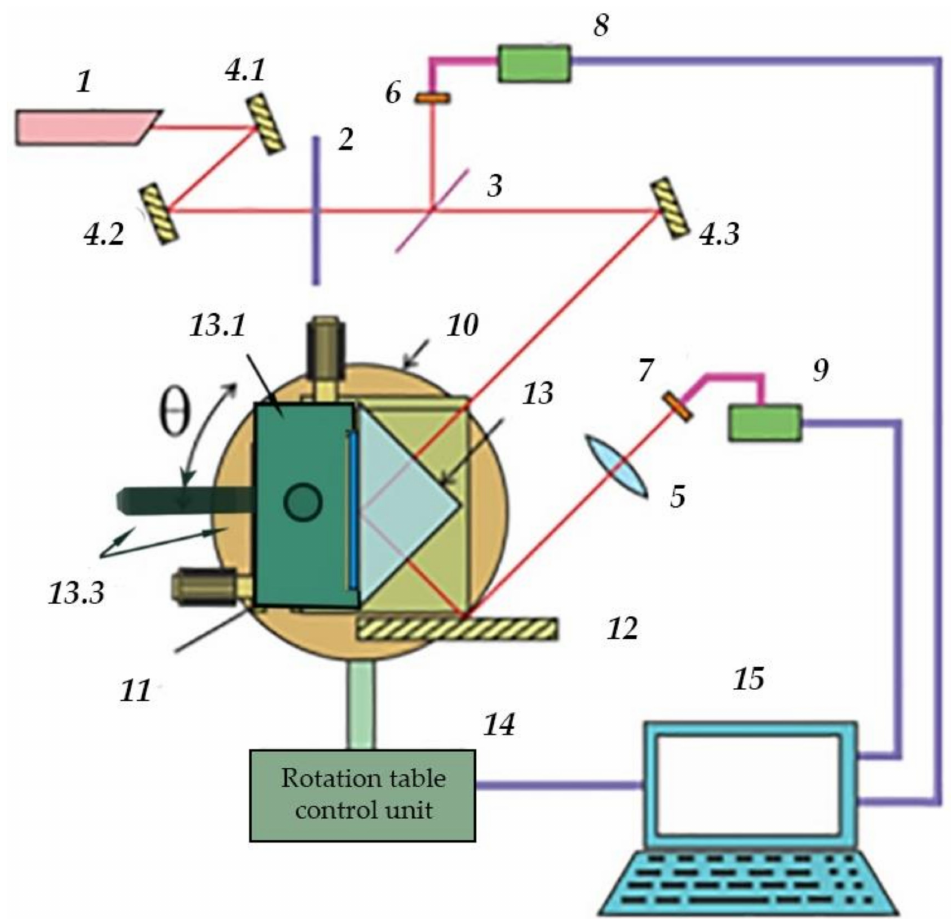
Figure 1. Measuring unit (1, He-Ne laser; 2, polarizer; 3, divider; 4.1–4.3, mirrors; 5, focusing lens; 6–7, photo sensors; 8–9, analog-digital converter; 10, rotary platform; 11, adjustment linear translators; 12, angle reflector mirror; 13, input prism; 13.1–13.3, cuvettes with input/output pipes; 14, rotary platform controller; and 15, control computer).